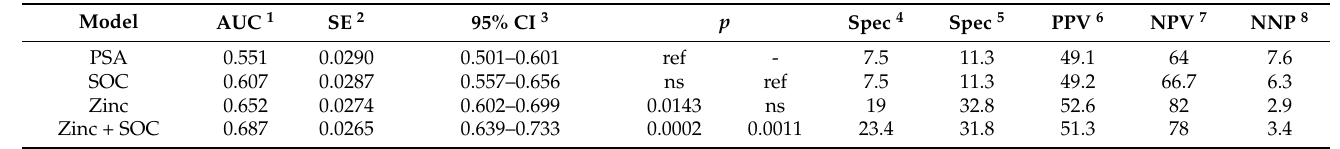
Table 4. Diagnostic models and accuracy.